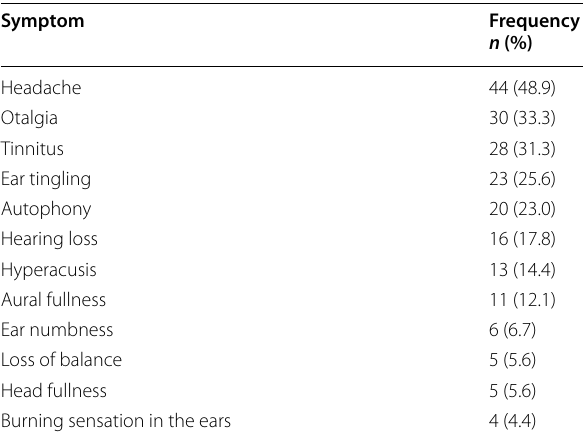
Table 2 Symptoms experienced by subjects call